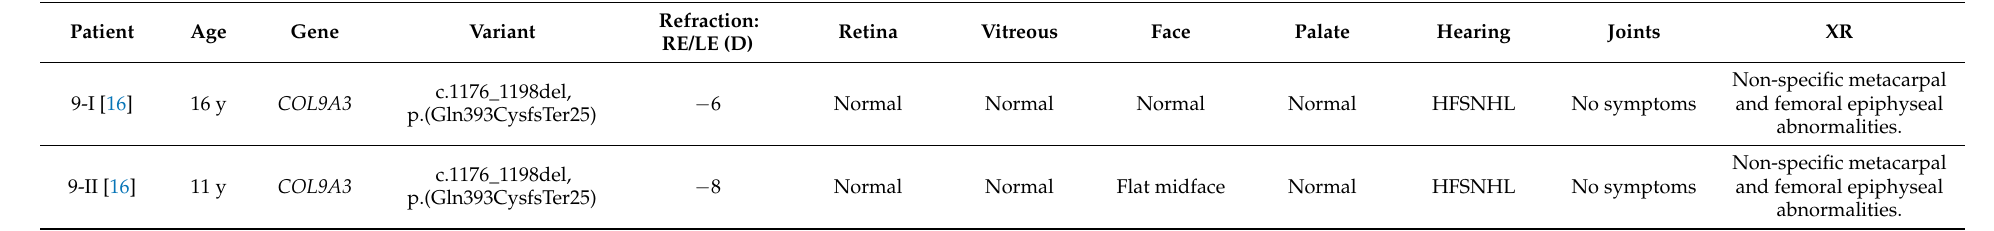
Table 3. Clinical features of patients with recessive pathogenic variants in COL9A3 . All variants mentioned are homozygous in the affected patient unless stated